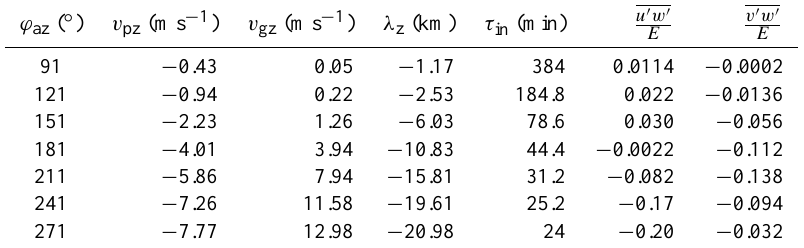
Table 4a. The dependence of the vertical phase velocity (2nd column), vertical group velocity (3rd column), vertical wavelength (4th column), the intrinsic period (5th column), vertical flux of zonal momentum to energy ratio (6th column), and vertical flux of meridional momentum to energy ratio (7th column) on the azimuth (1st column) of a gravity wave with period τ = 45min and horizontal phase speed v ph = 35ms − 1 (horizontal wavelength λ h = 94 . 5km) assumes that the wave is propagating in an eastward wind with wind speed u h = 30 . 9ms − 1 ( azimuth angle ϕ az = 90 ◦ ) in the mesosphere over the MU radar site. The results were obtained by gravity wave dispersion relation.